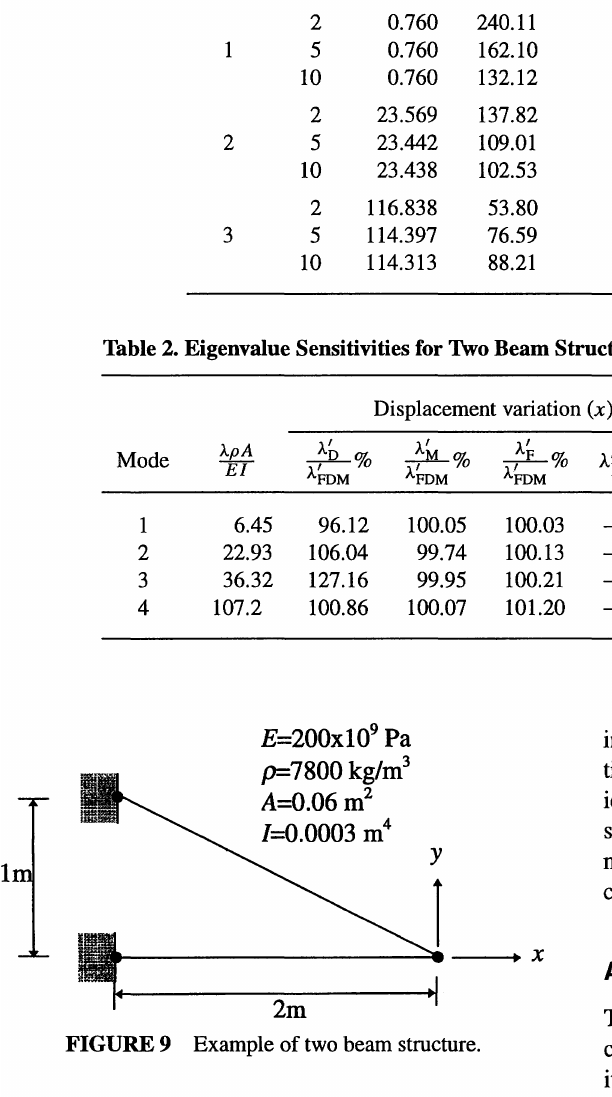
Table 2. Eigenvalue Sensitivities for Two Beam Structure Displacement variation (x)